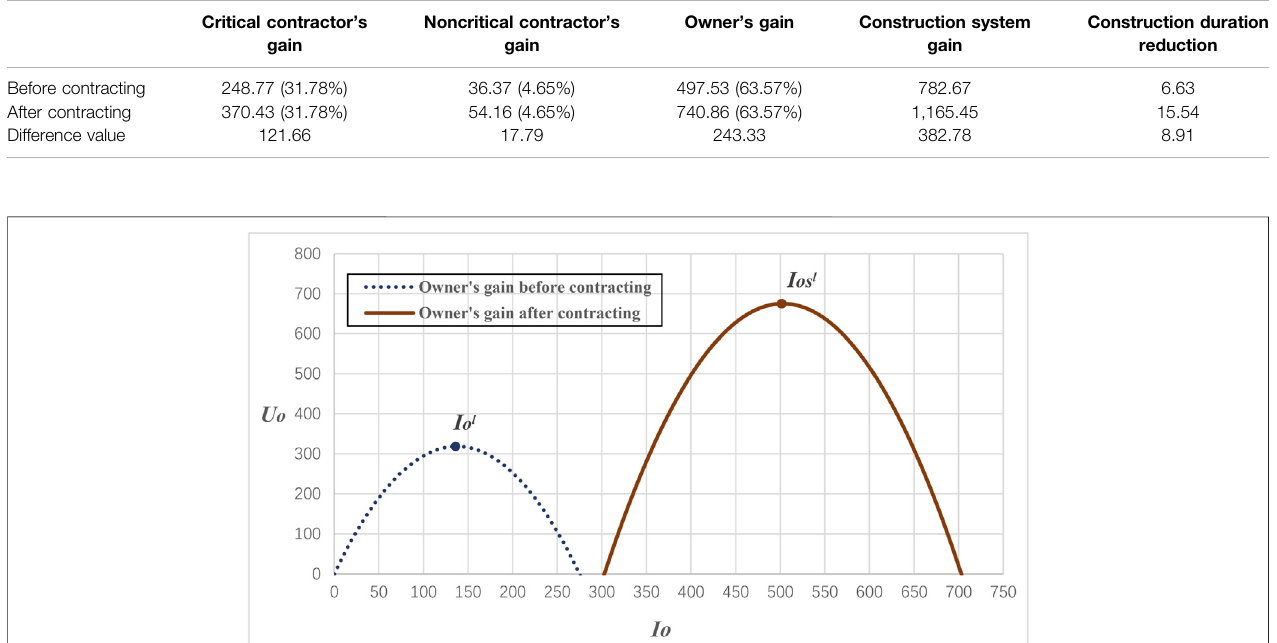
FIGURE 5 | The owner ’ s gain function before and after contracting in Scenario II.